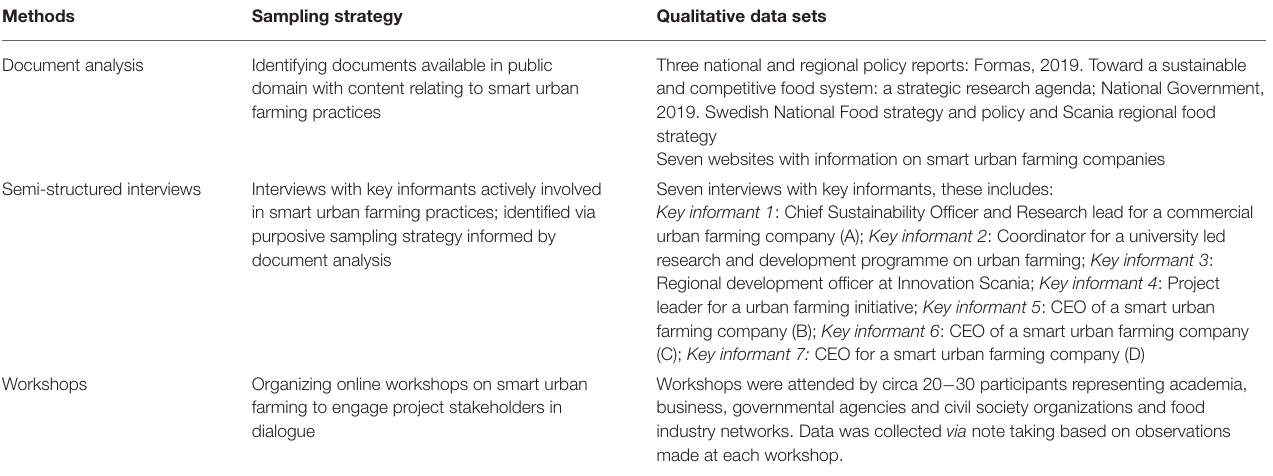
TABLE 1 | Methods for data collection and